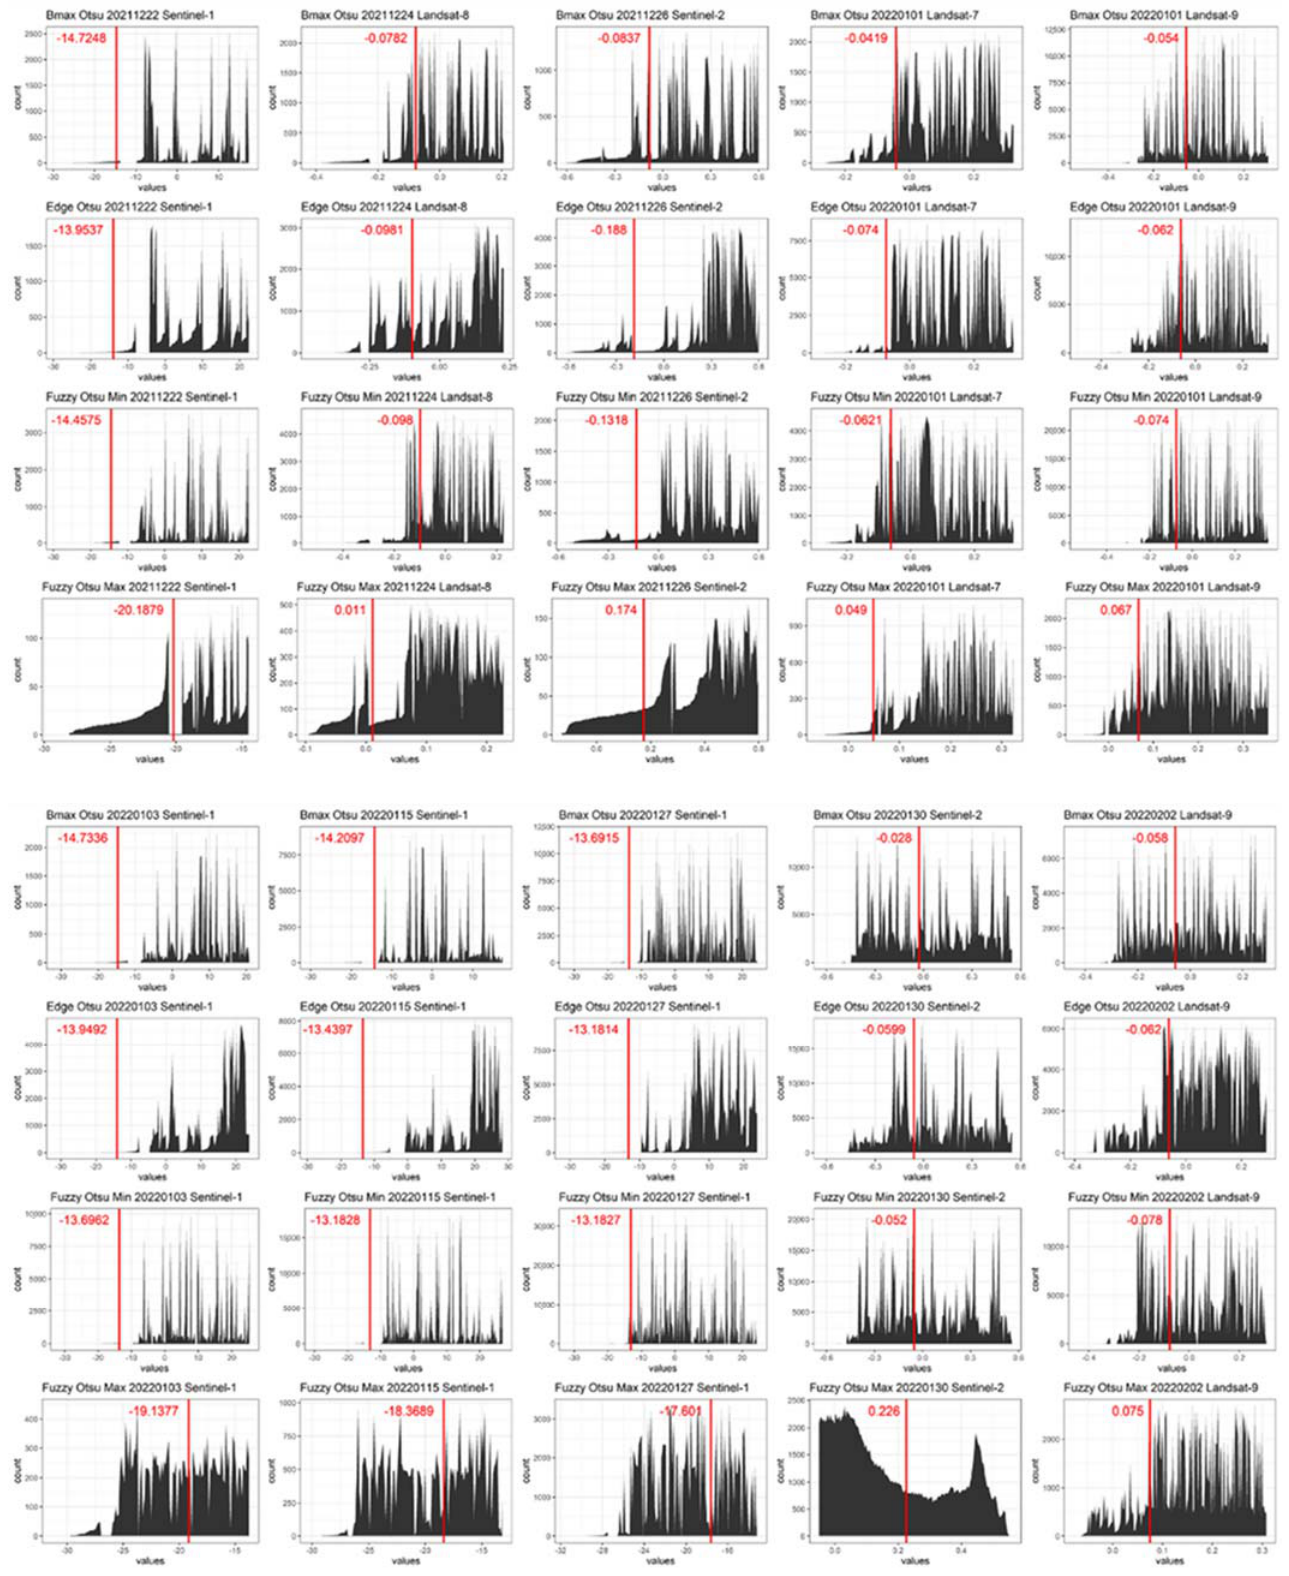
Figure 6. The histograms and the threshold values identified by each algorithm for the satellite im ‐ agery.